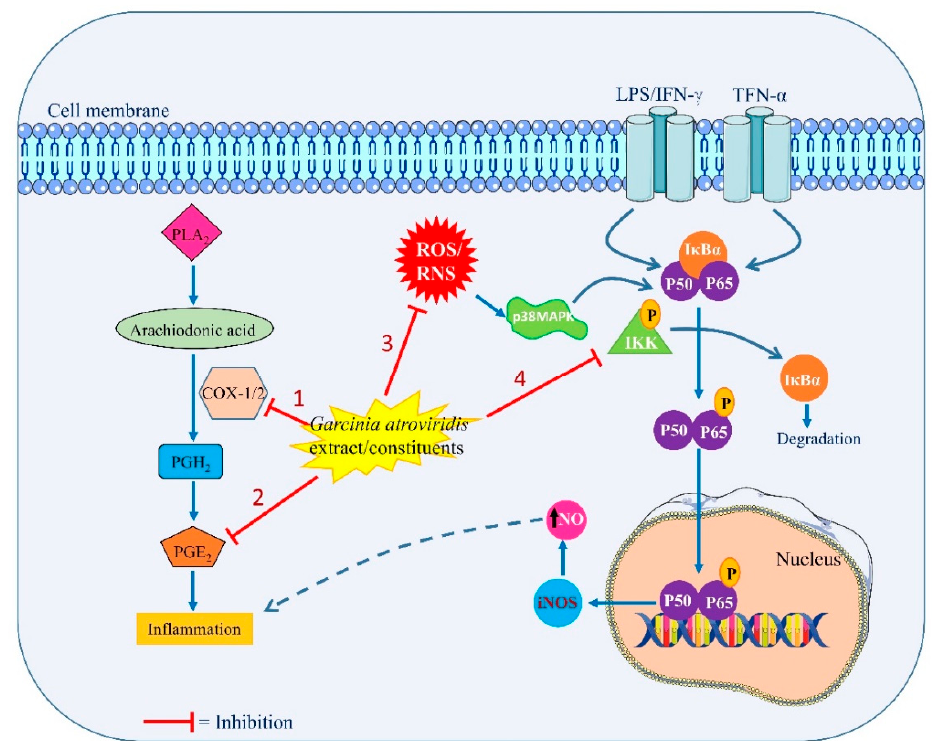
Figure 4. Probable anti-inflammatory mechanisms of action of G. atroviridis or its constituents by: (1) inhibiting COX1/2 enzymes activity, (2) affecting the PGE2 production, (3) reducing the ROS/RNS production, and (4) targeting MAPK and NF- κ B signaling pathways. PLA2 (Phospholipase A2), COX1/2 (cyclooxygenase 1 and 2), PGH2 (prostaglandin H2), PGE2 (prostaglandin E2), ROS (reactive oxygen species), RNS (reactive nitrogenous species), iNOS (inducible nitric oxide synthase), and MAPK (mitogen-activated protein kinase).